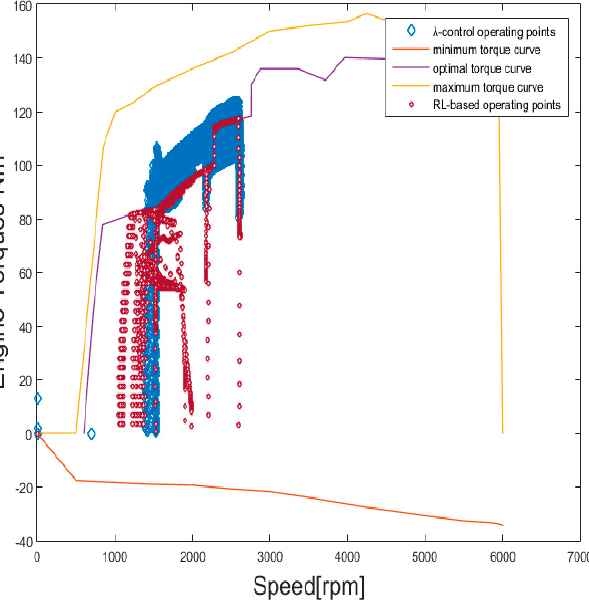
Figure 14. ICE operating point variation of the proposed L-Control algorithm and Rl-based strategy.